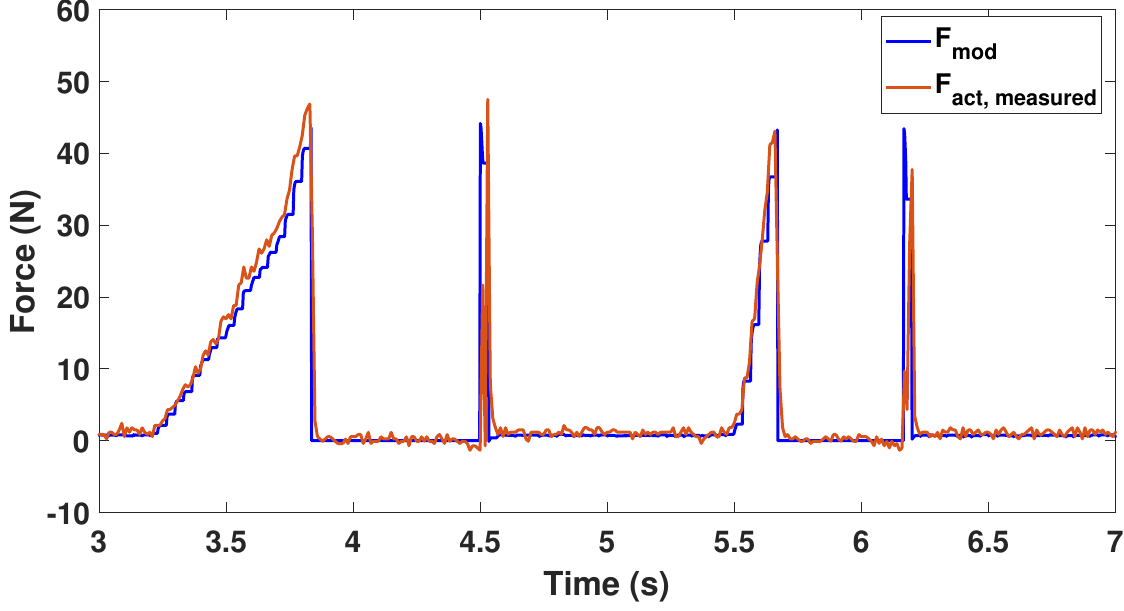
Figure 18. Measured actuator coil force compared to the